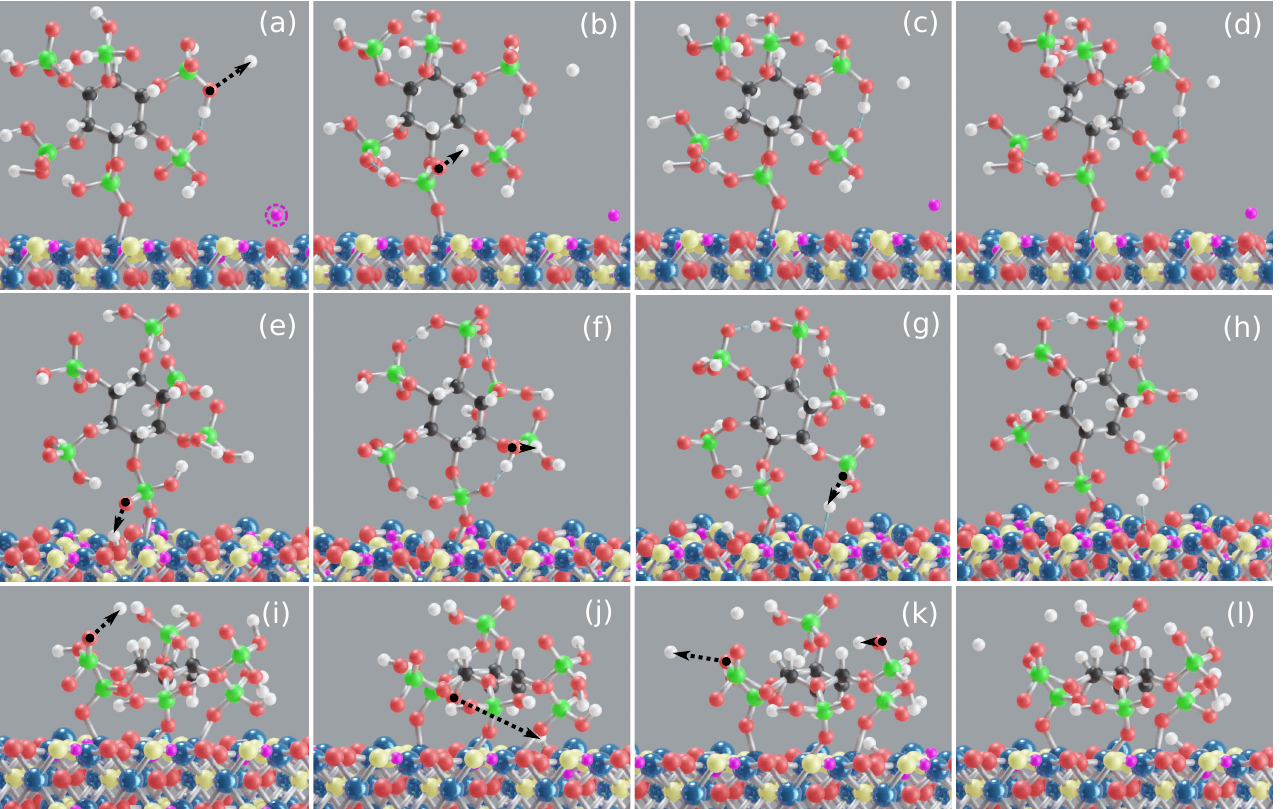
Figure 4. Snapshots of goethite–IHP–water models along the simulation trajectory. In M(1) motif, proton transfer from IHP to water and from goethite surface oxygen to water ( a ), intramolecular HB and a proton transfer from IHP to water ( b ), and M(1) motif at 17 and 25 ps ( c , d ). In M(2) motif, proton transfer from IHP to surface ( e ), protons transfer from IHP to water ( f , g ), and M(2) motif at 25 ps ( h ). In 3M motif, three proton transfers from IHP to water ( i , k ) and a proton transfer from IHP to surface ( j ), 3M motif at 25 ps ( l ). As proton transfer events are common in these interactions, the goethite surface hydrogen atoms and IHP’s hydrogen atoms are shown in violet and white colors to avoid confusion. Moreover, the surrounding water is ignored here for better visualization. Snapshots that show proton transfers are from the equilibration